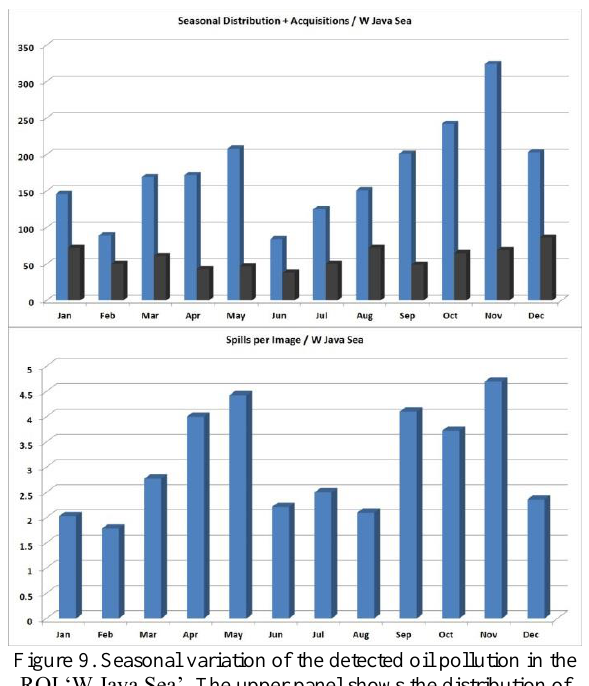
Figure 9. Seasonal variation of the detected oil pollution in the ROI ‘W Java Sea’. The upper panel shows the distribution of the numbers of oil spills that were found in 130 ENVISAT ASAR images. The lower Panel shows the respective distribution of the average numbers of oil spills per SAR image.